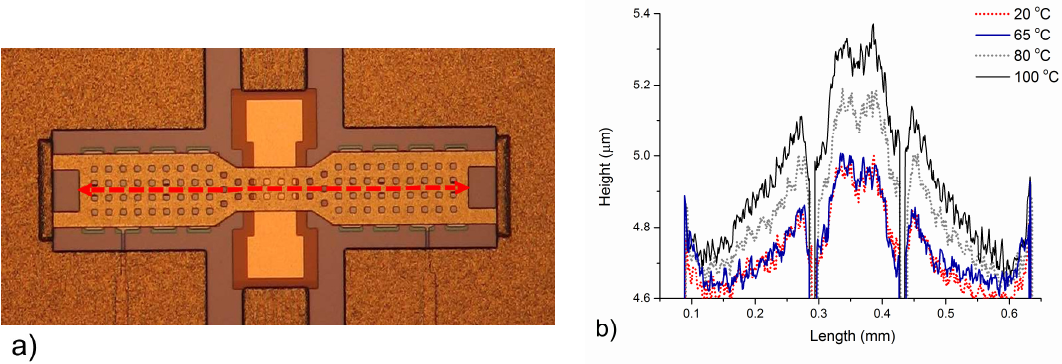
Figure 5. Micrograph ( a ) and surface profile ( b ) of the mobile membrane of a MEMS capacitive switch at different temperatures. The surface profile was measured with an optical profiler along the red dashed line ( a ).